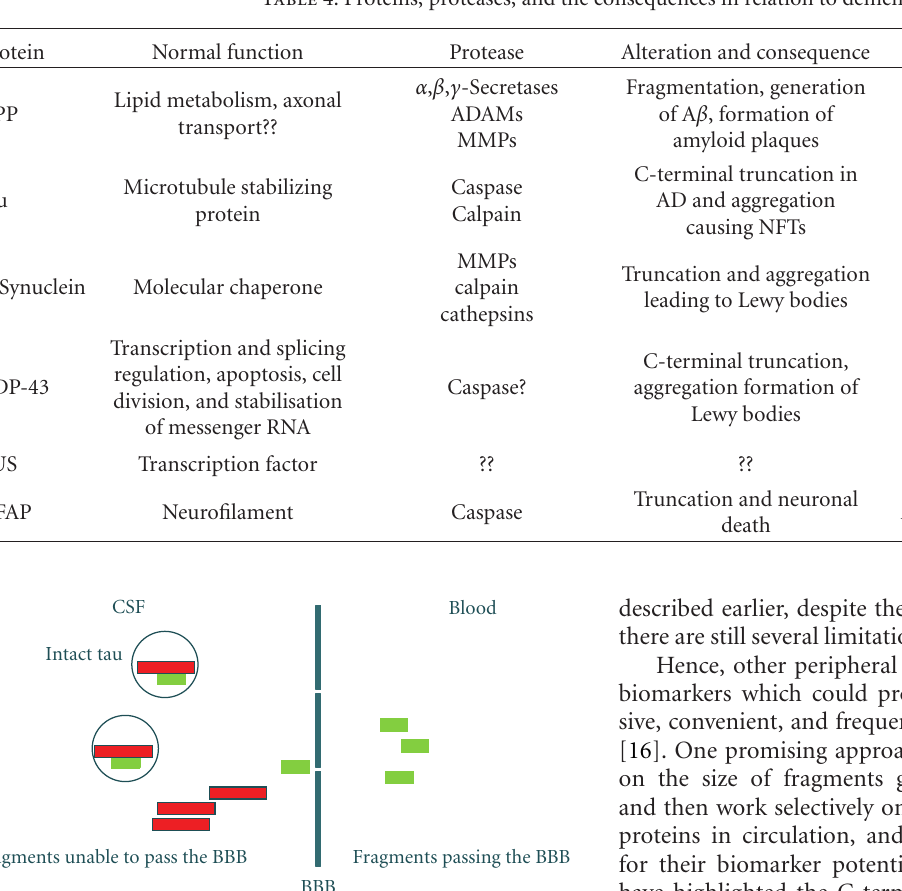
Table 4: Proteins, proteases, and the consequences in relation to dementia.